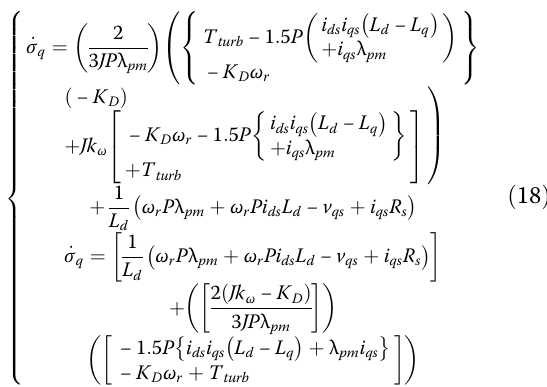
For the evaluation of controlled voltages, a second Lyapunov function is calculated using (16) – (18). Error signals of the rotational speed tracking and